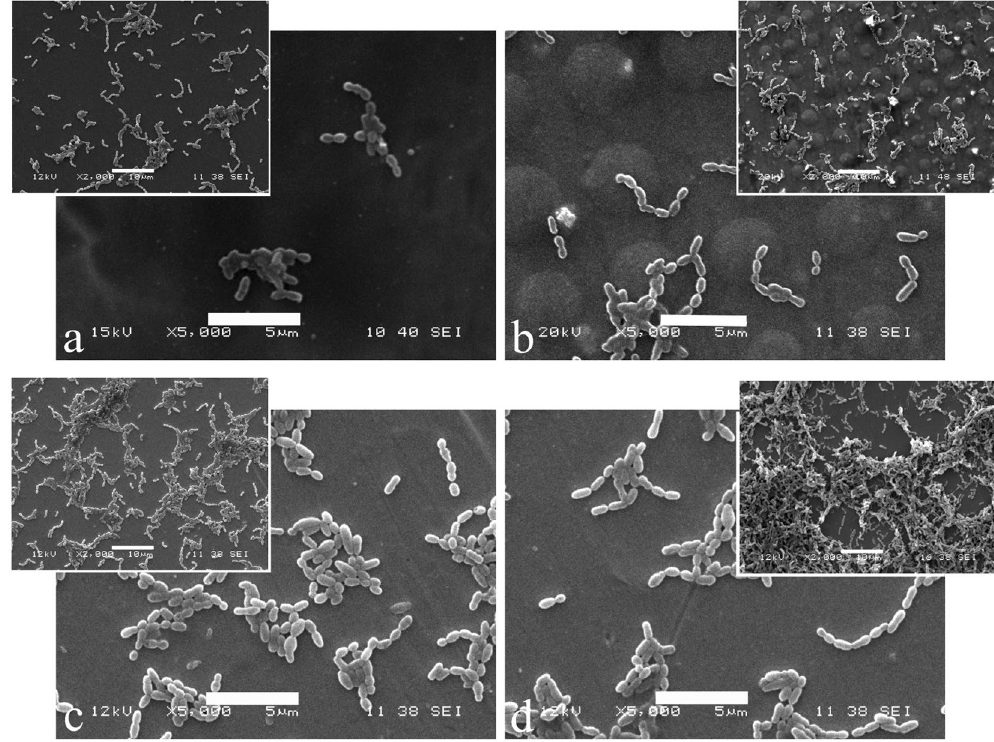
Figure 8. SEM photographs of bacterial colonization on SS-TiO 2 coated ( a ), SS-TiO 2 micropatterned ( b ), SS polished ( c ) and unexposed SS polished ( d ). Scale is 5 µ m. Inserts show interaction at 2000 × . Scale in the inserts is 10 µ